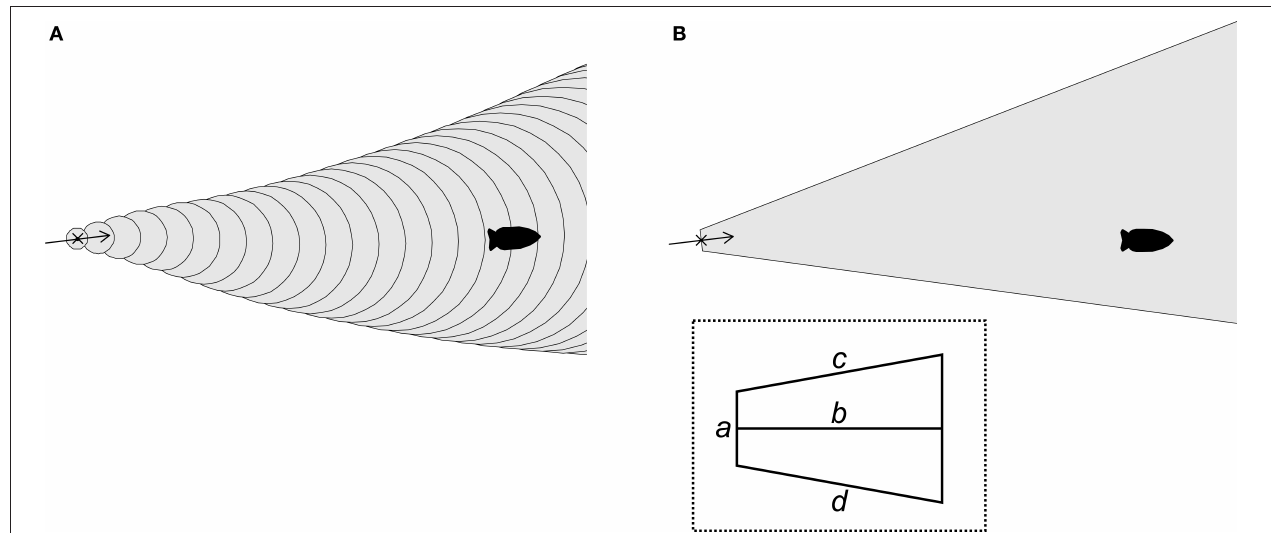
defined by a trapezoidal region (outlined, cut off at right) oriented around the odor source (x) by the current (arrow). Inset: trapezoid schematic indicating segments for which dimensions are given in Table 1 . Movies in Supplementary Material demonstrate the differences between the two simulation